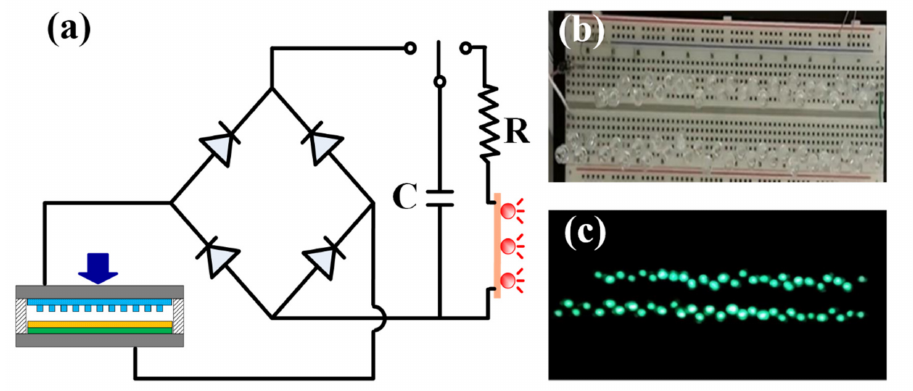
Figure 10. ( a ) Full-wave bridge rectifier circuit used to charge capacitor and power 60 LED bulbs. ( b ) Series arrangement of LED bulbs plugged into breadboard. ( c ) Illumination of LED bulbs by TEG device.